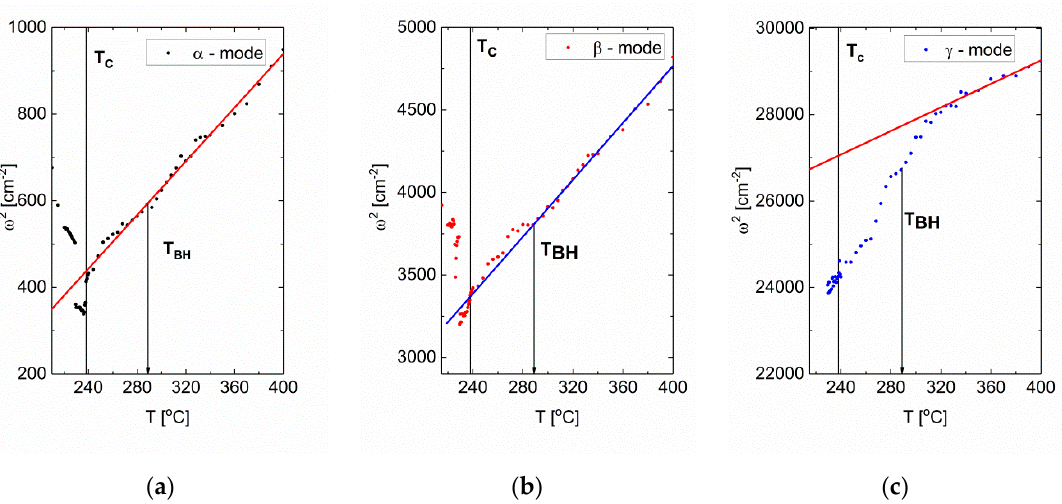
Figure 7. Temperature dependence of the squares of modes’ frequencies ( a ) α , ( b ) β and ( c ) γ . The red and blue lines match in high temperature range. The temperature defined in [34] was determined as T BH.